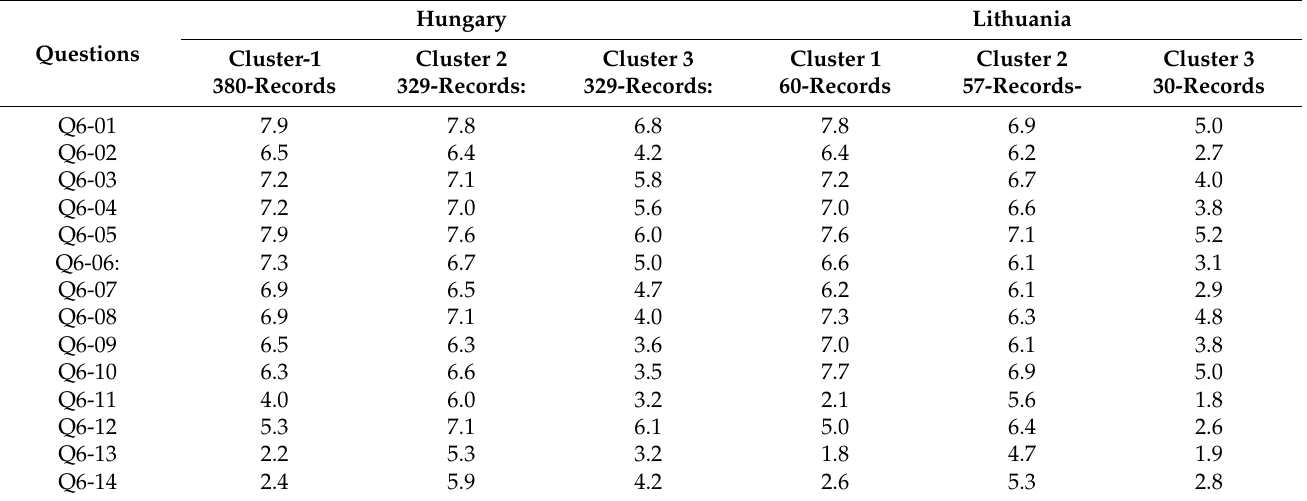
Table 1. Comparison of